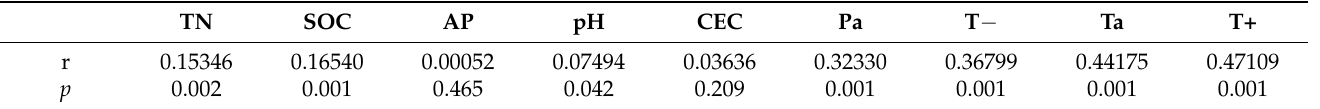
Table 5. Correlations between bacterial community composition and climate factors/soil properties assessed by Mantel tests.